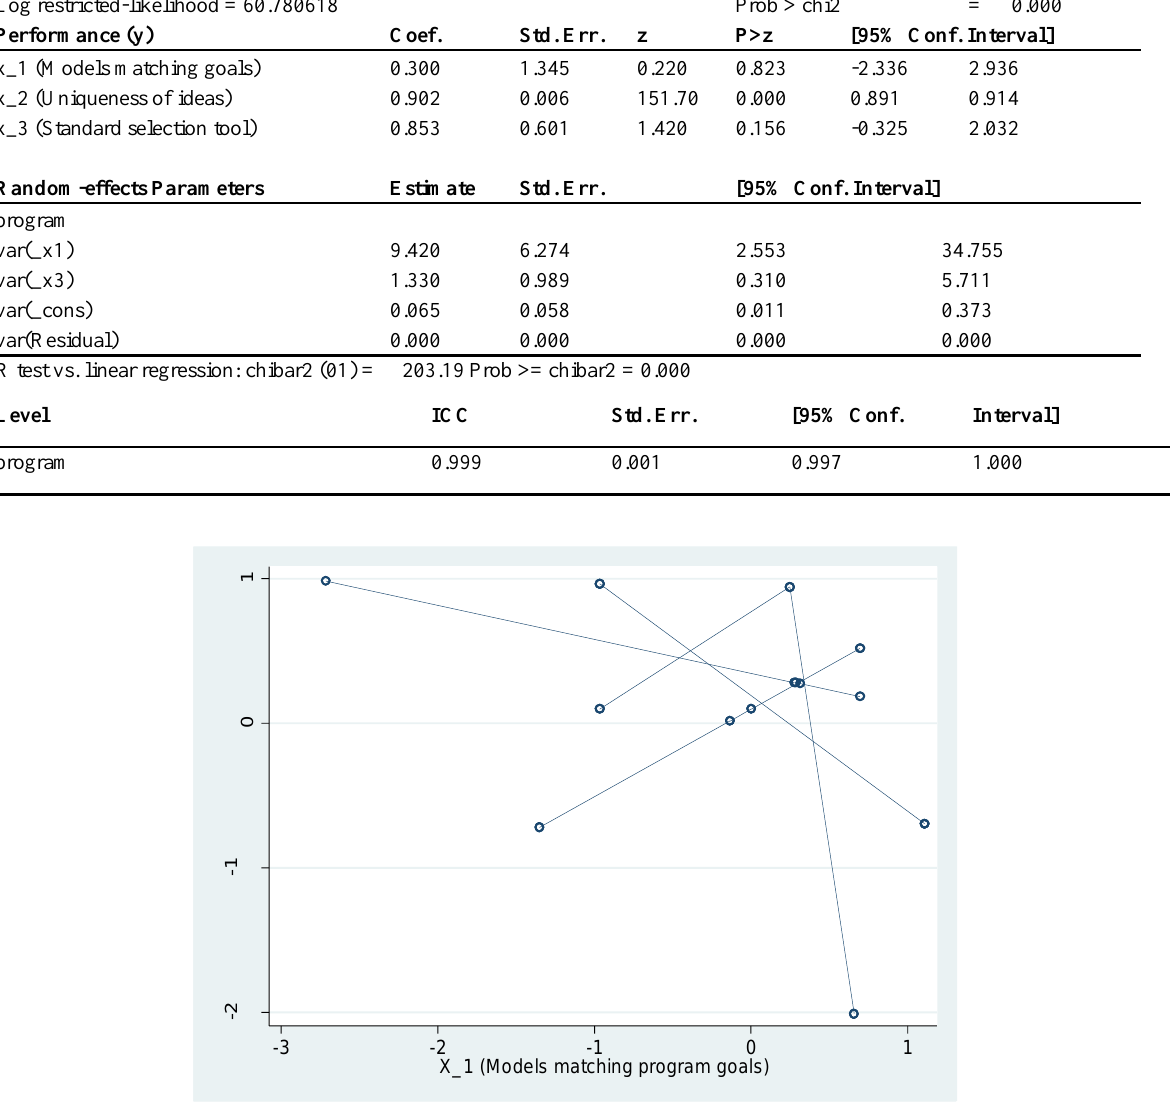
Figure 3 : Random Slopes of Models than match Program